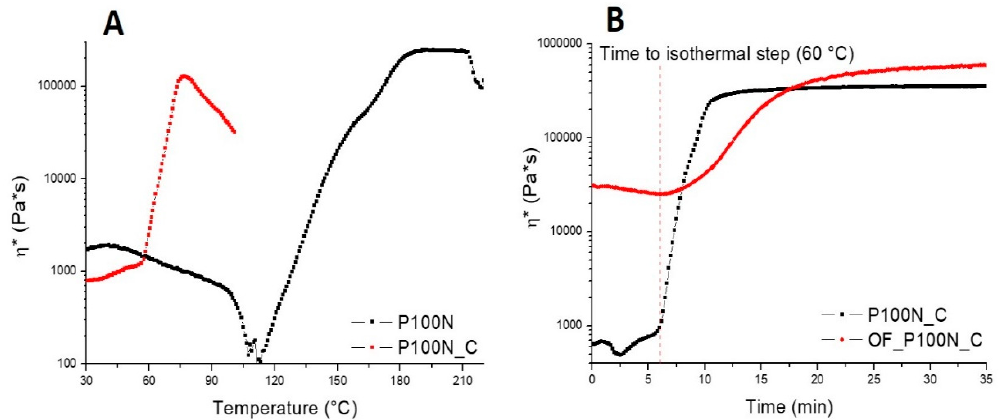
Figure 1. ( A ) Rheological dynamic curves of the P100N and P100N_C samples; ( B ) isothermal curves of the P100N_C and OF_P100N_C samples at 60 °C.